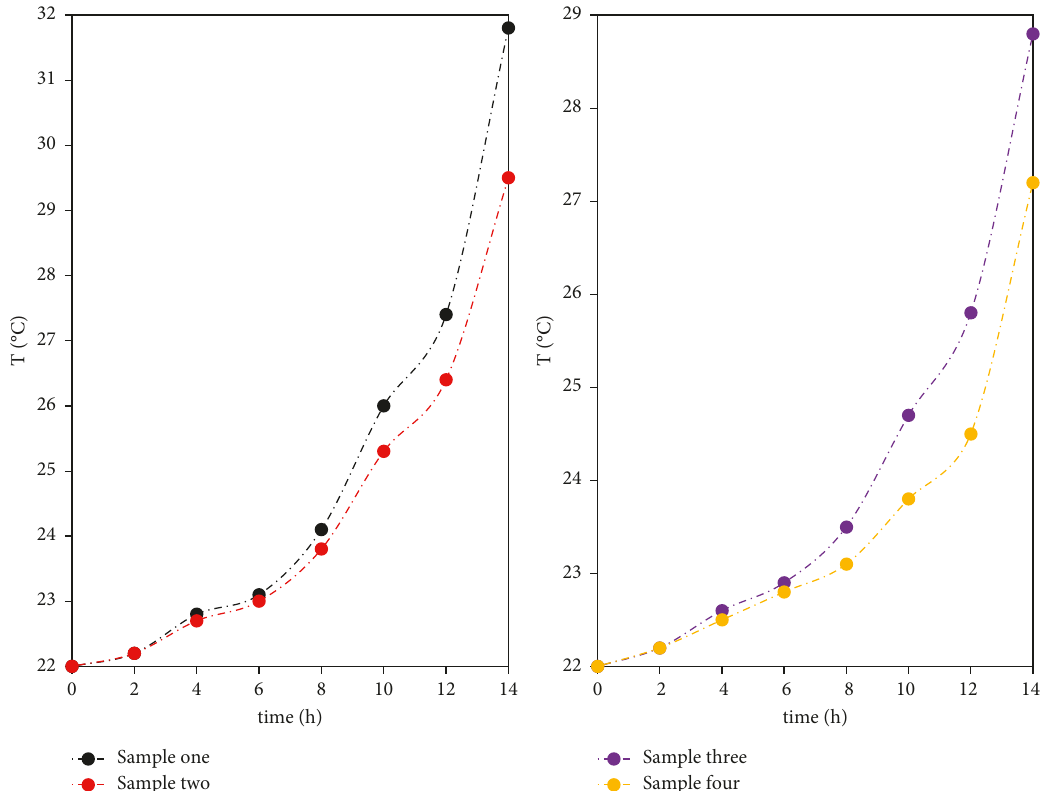
Figure 8: The temperature change diagram of the low temperature side when the western wall samples with different ratios absorb heat.